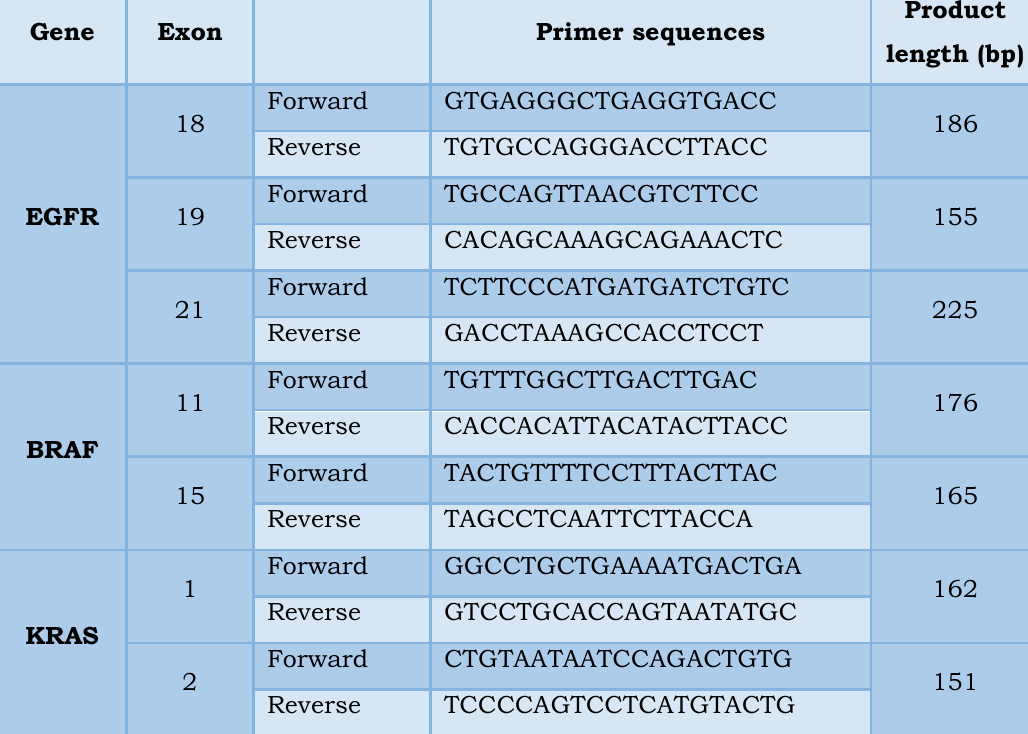
Product length (bp)